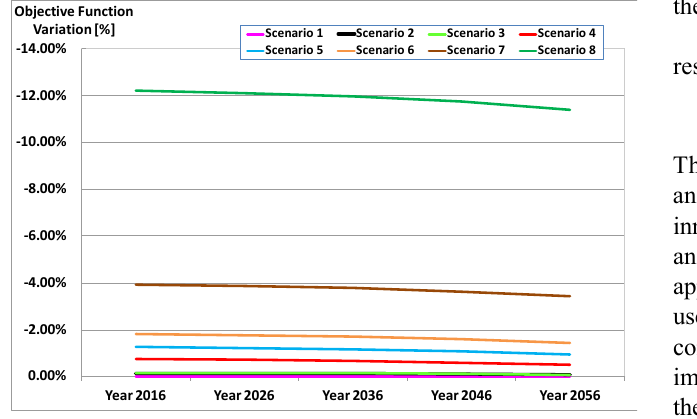
Fig. 2. Variation of objective function value in average conditions during the analysed time period (2016-2056).